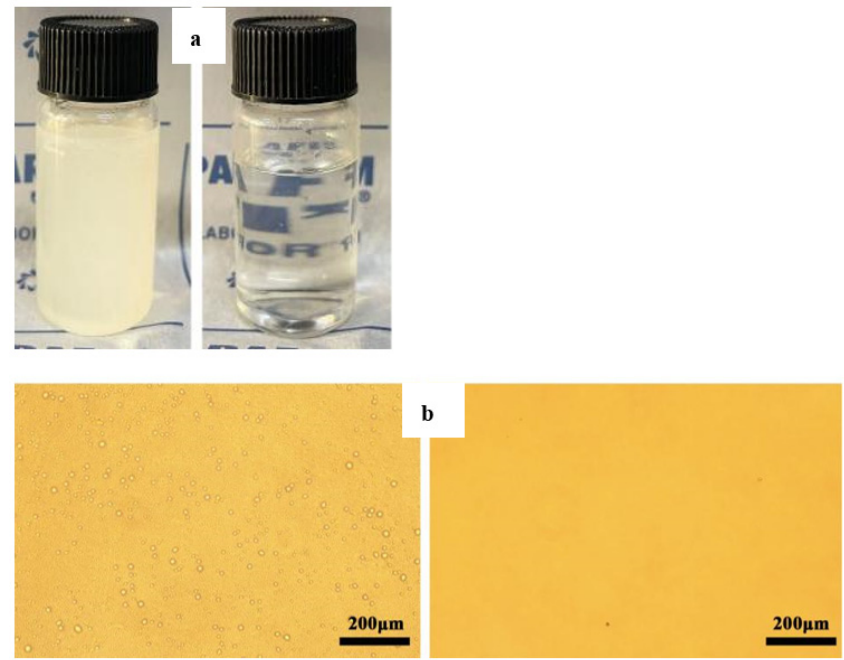
Figure 5. Images of water-in-CCl 4 micro-sized emulsions before (left) and after (right) permeation through the modified filter paper. Photos of emulsion feed and filtrate ( a ), the optical microscopy images of feed and filtrate ( b ).